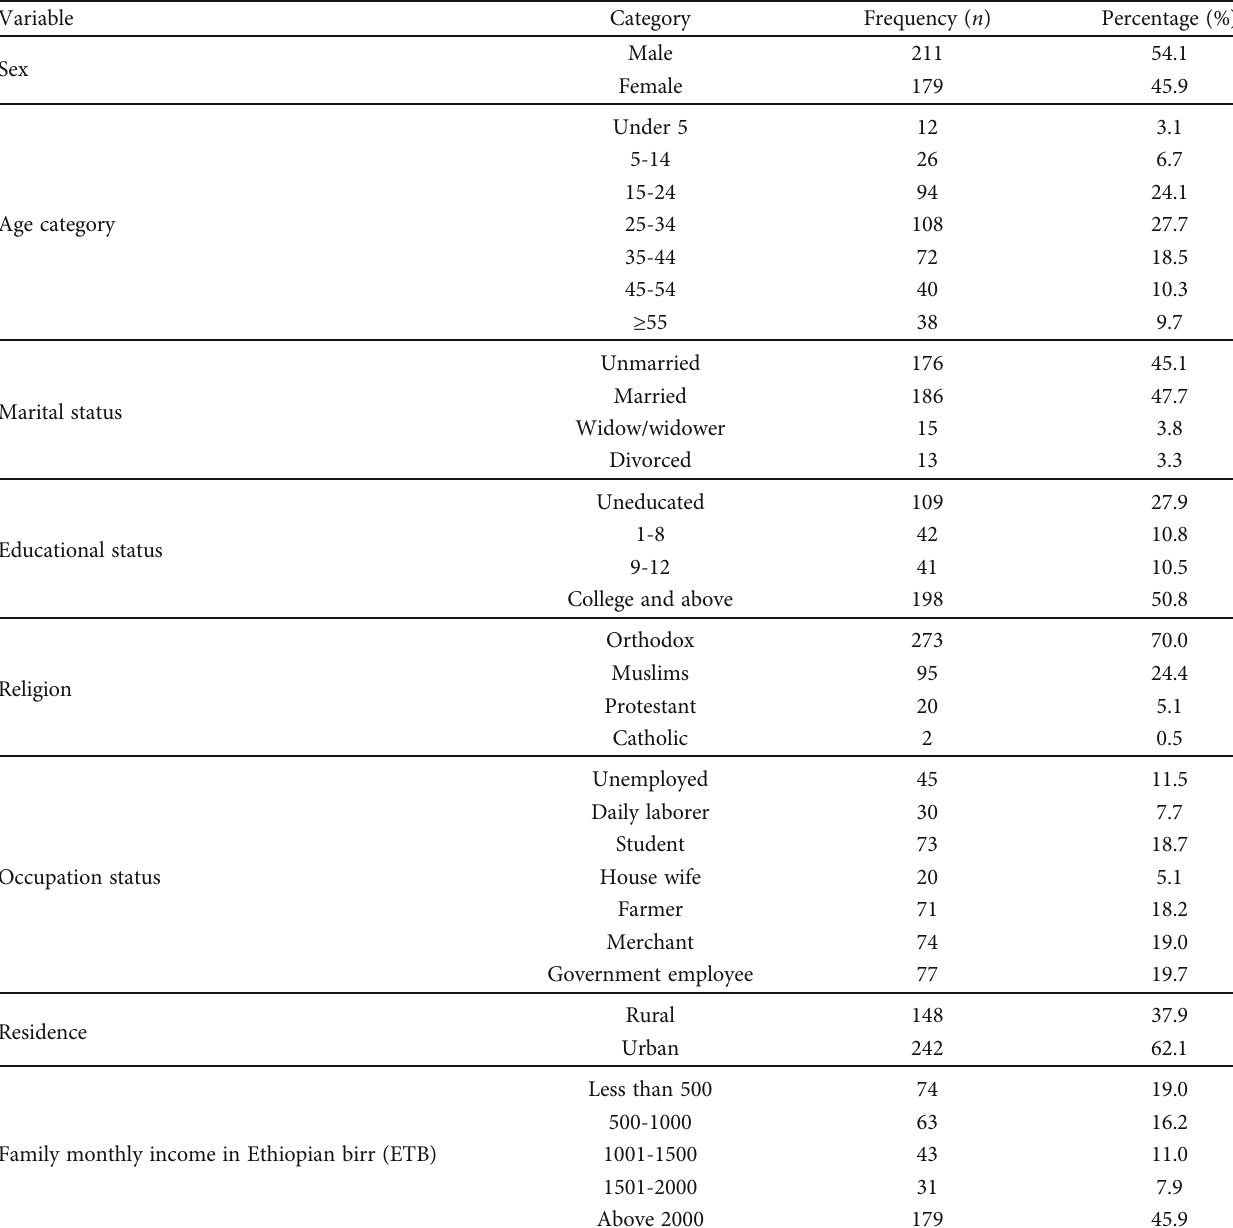
Table 1: Sociodemographic characteristics of respondents in Mekaneeyesus hospital, South Gondar, northwestern Ethiopia, 2018.